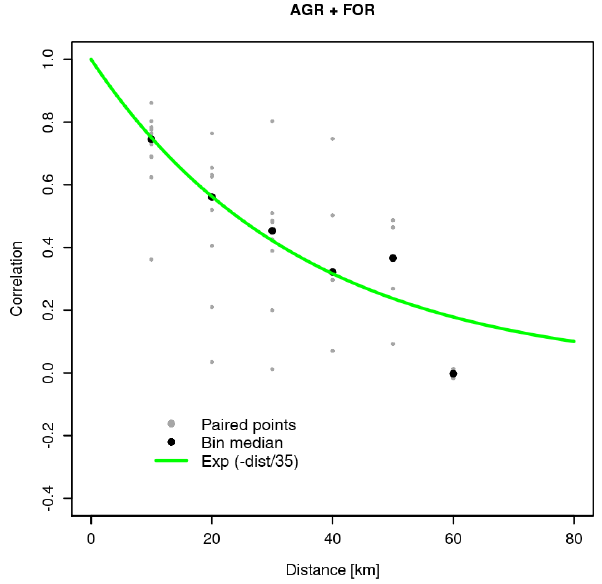
Figure 8. Distance correlogram between VPRM10 and aircraft NEE measurements. Black dots represents the different aircraft grid points pairs; black circles represent 10km scale binned data.